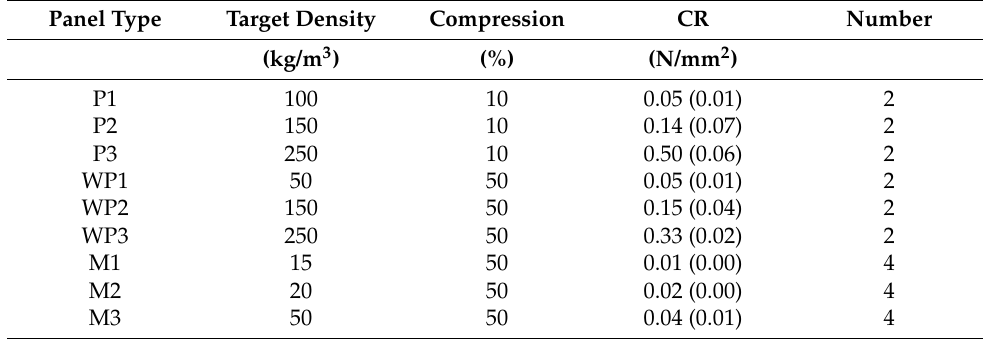
Table 4. Compression resistance of moss samples (SD in brackets).